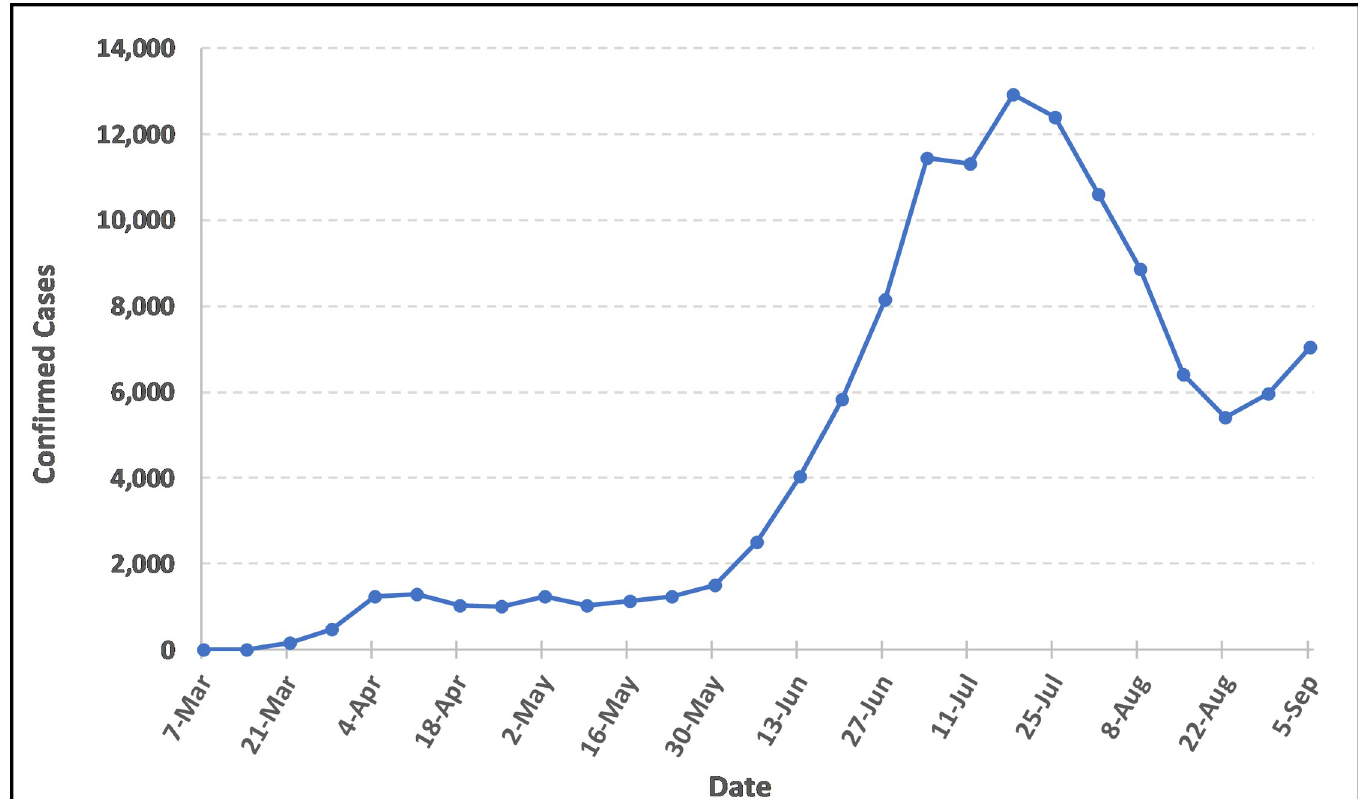
Fig 2. New South Carolina COVID-19 confirmed cases per epi week (March 6 th –September 5 th , 2020).